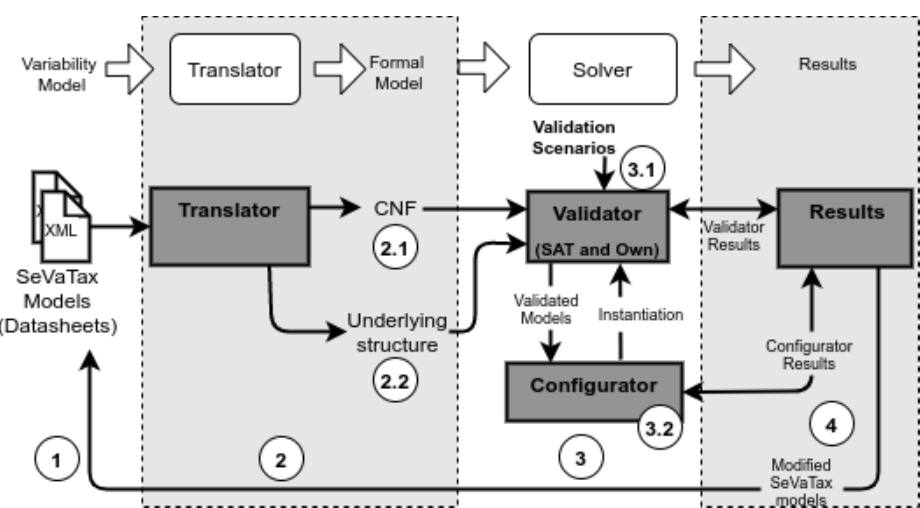
Figure 3. SeVaTax analysis